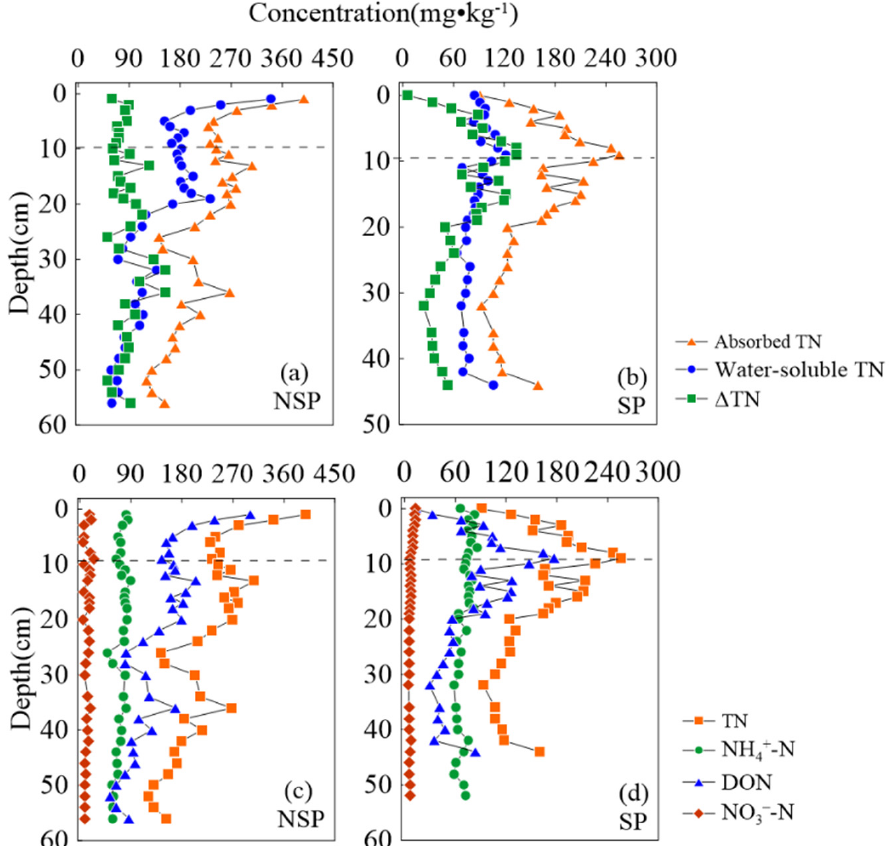
Concentrations of adsorbed total nitrogen (TN) ranged from 120.7 to 398.56 mg · kg − 1 in the NSP and from 91 to 255.7 mg · kg − 1 in the SP, with an average value of 233.9 and 159.2 mg · kg − 1 , respectively. The water-soluble TN ranged from 57.4 to 339.4 mg · kg − 1 and from 63.5 to 121.36 mg · kg − 1 (averaged 144.5 and 86.8 mg · kg − 1 ) in the NSP and SP (Table 2), respectively. The adsorbed TN was 1.4 to 2.7 times higher than that of the water-soluble TN. Meanwhile, the concentrations of nitrogen species displayed different seasonal variation; adsorbed TN in the sediment at 0–10 cm in the SP increased with depth, and there was no significant change in water-soluble TN (Figure 3).